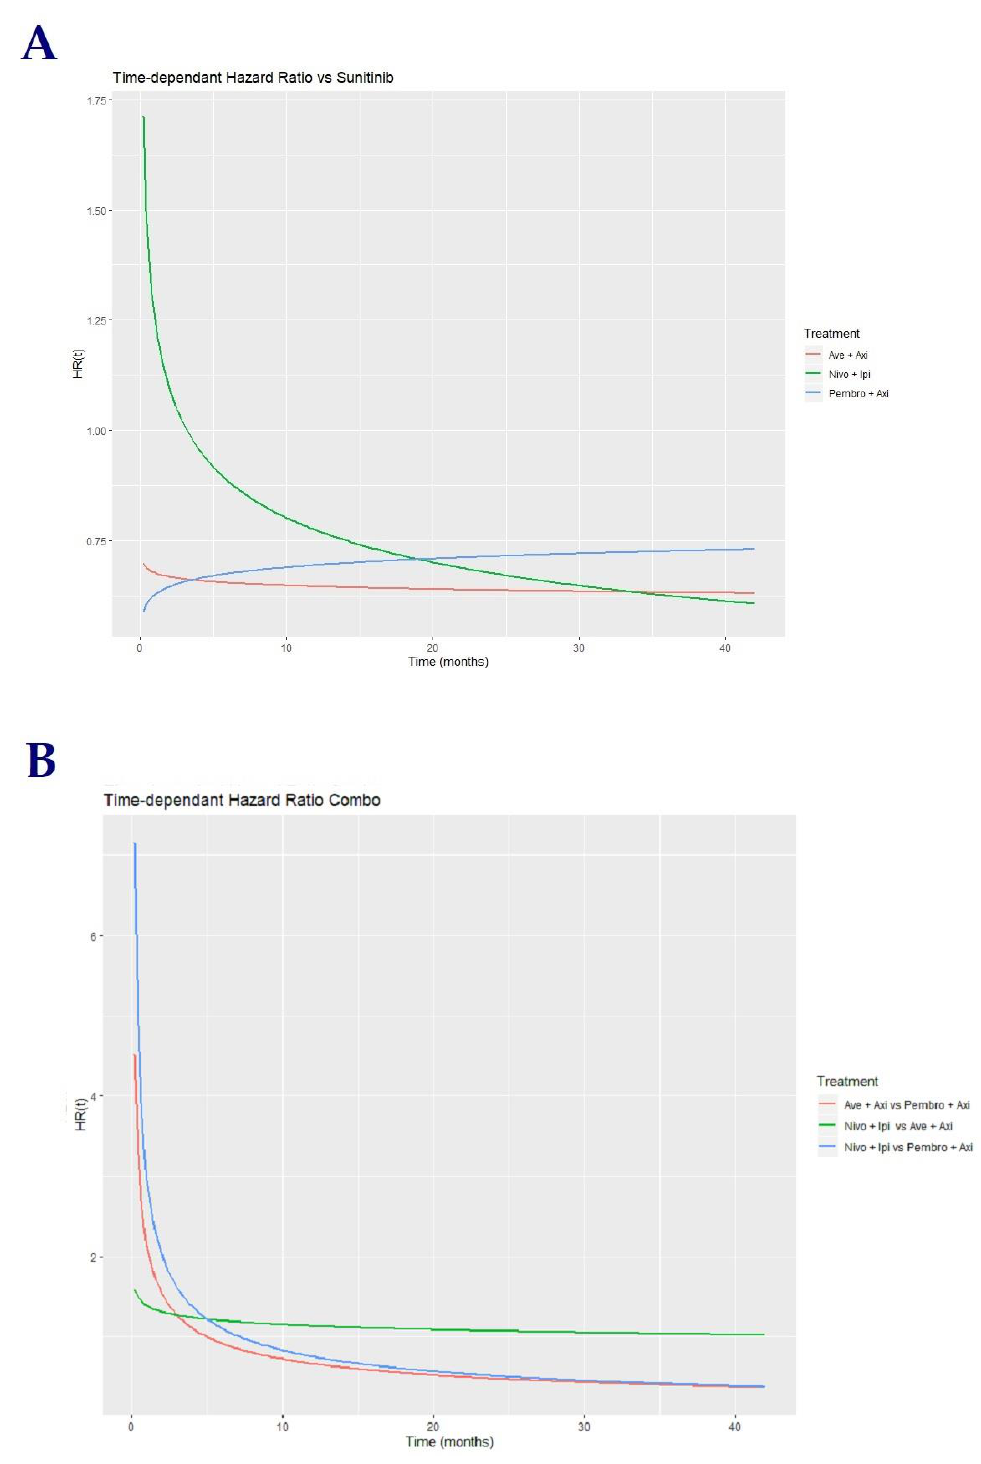
Figure 4. Time-dependent HRs for PFS of combinations. ( A ) Time-dependent hazard ratio vs. sunitinib. ( B ) Time-dependent hazard ratio between combinations.